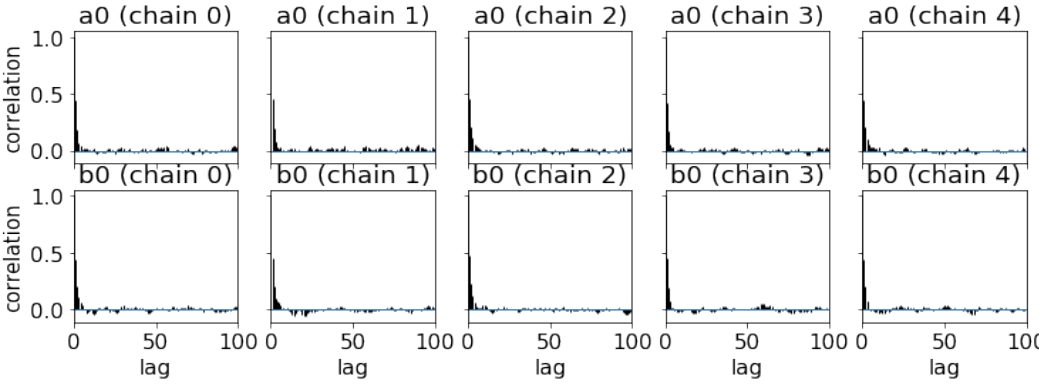
Figure 10. Autocorrelation plots for model H 0